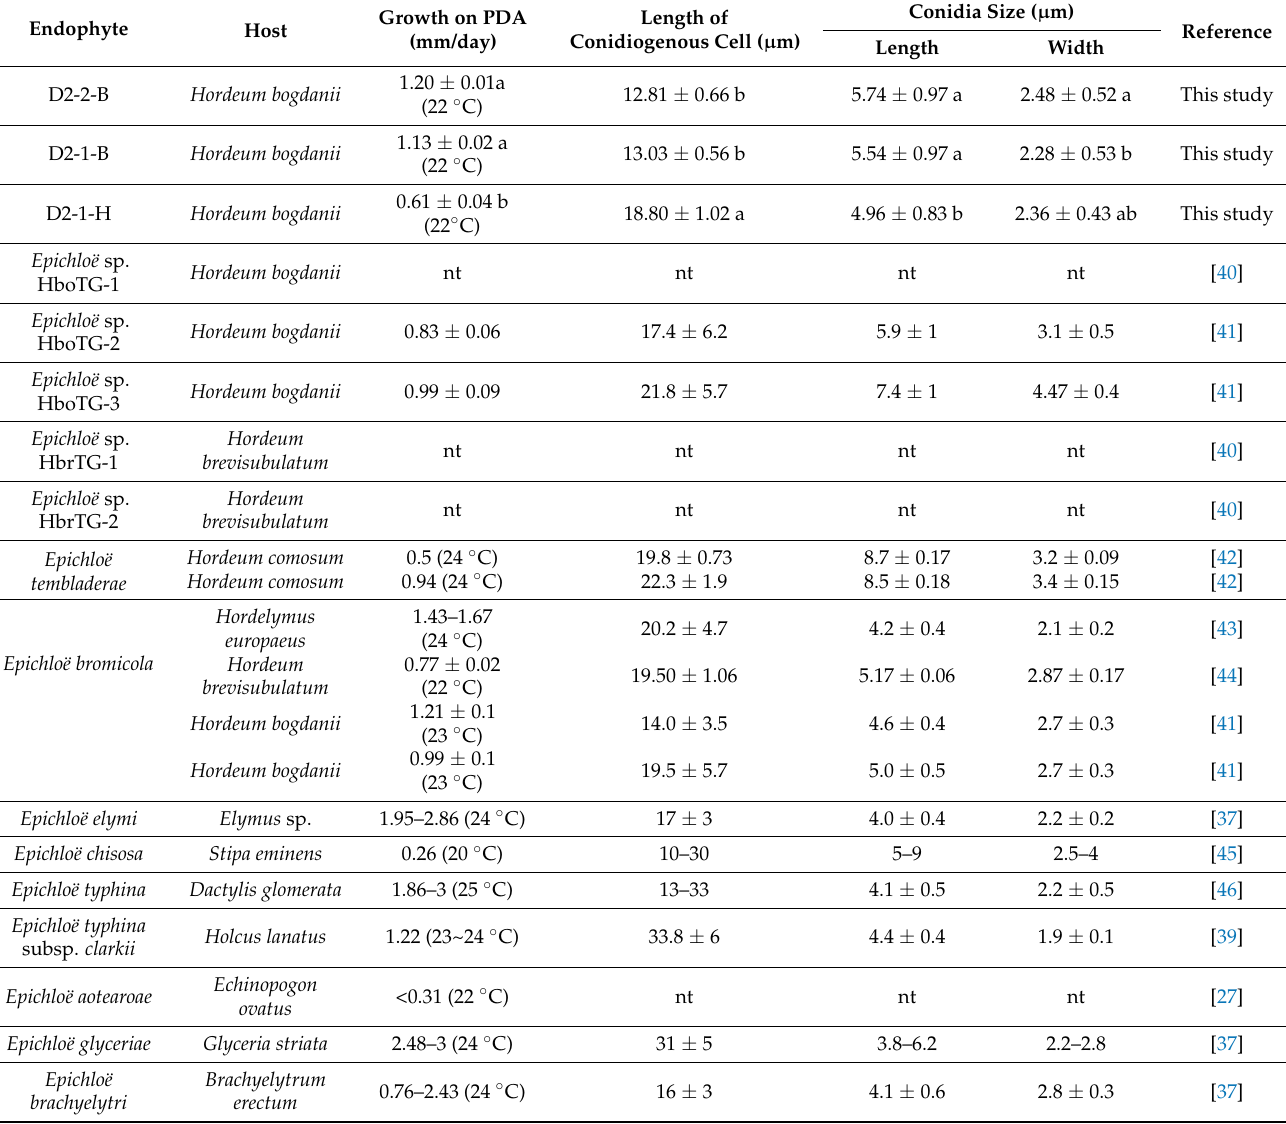
Table 1. Morpho-physiological comparison of Epichloë isolates in this study with selected Epichloë